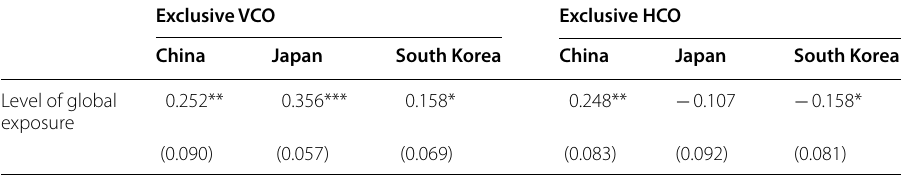
Table 6 Logit regression models on exclusive VCO and exclusive HCO